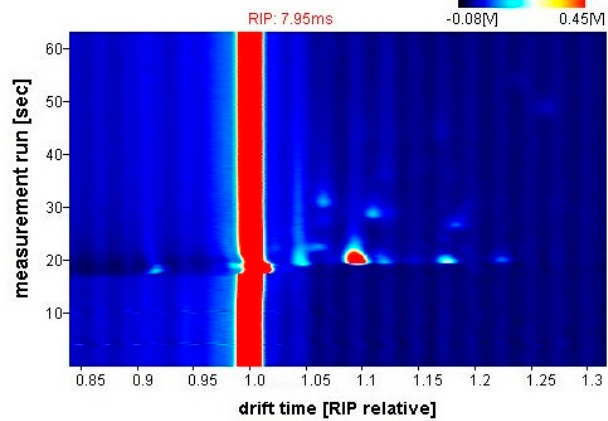
Figure 5. G.A.S. BreathSpec GC-IMS output example (CD patient).